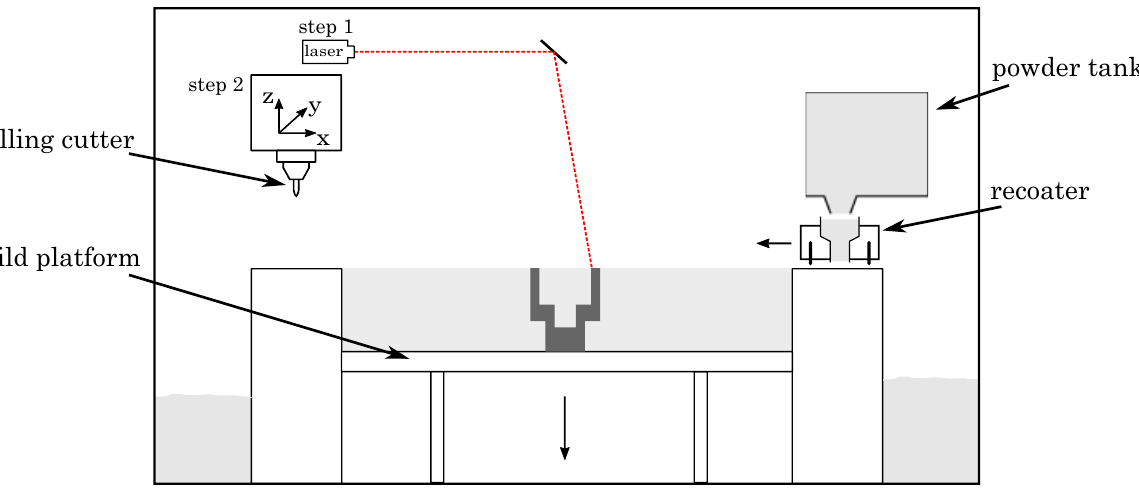
Figure 1. Hybrid manufacturing